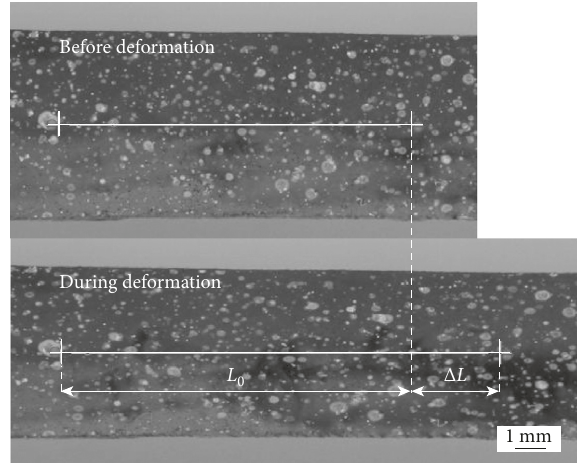
Figure 1: Measurement of strain by image correlation. The dis- tance between the same two objects on the gauge part of the specimen is measured during